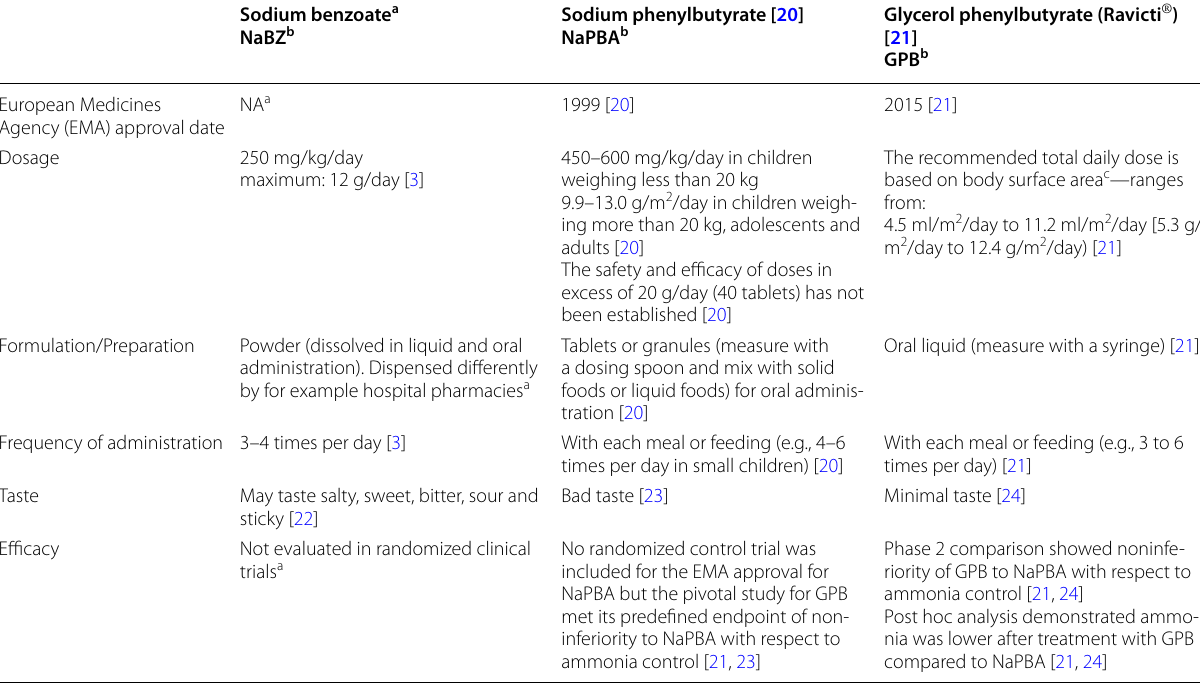
a No Summary of Product Characteristics is available as NaBZ is not an approved drug. Available as special needs product in UK and may be available as named patient use in additional countries. NaBZ is a chemical and food